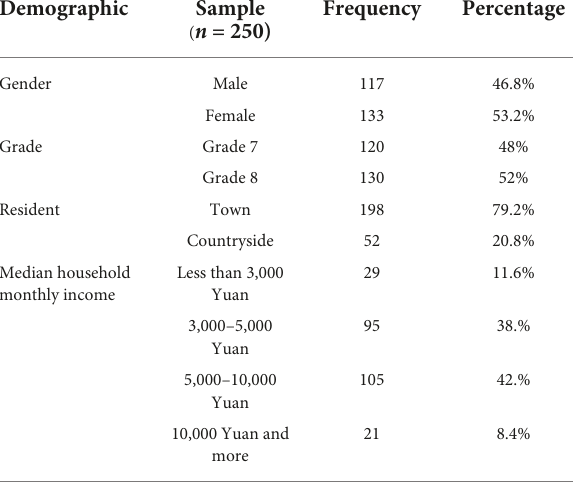
TABLE 2 Descriptive summary of socio-demographic profile of